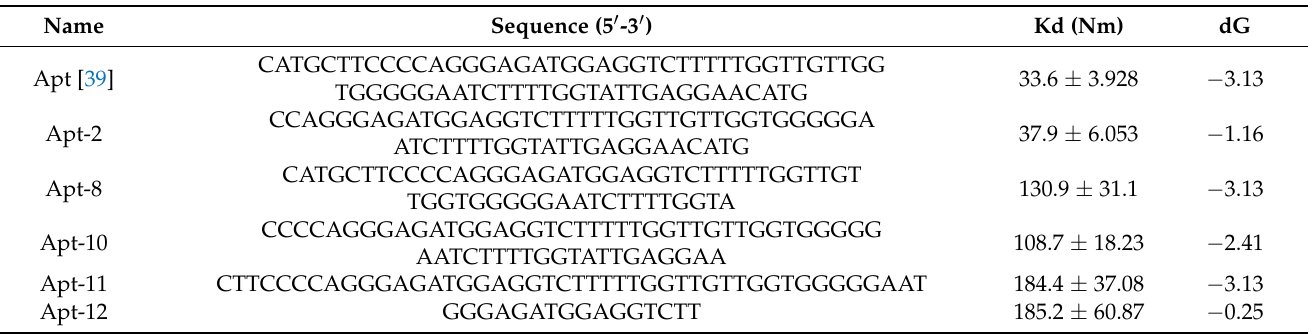
Table 1. Primitive and truncated aptamer sequences (5 (cid:48) -3 (cid:48) ), dissociation constants (Kd), and dG